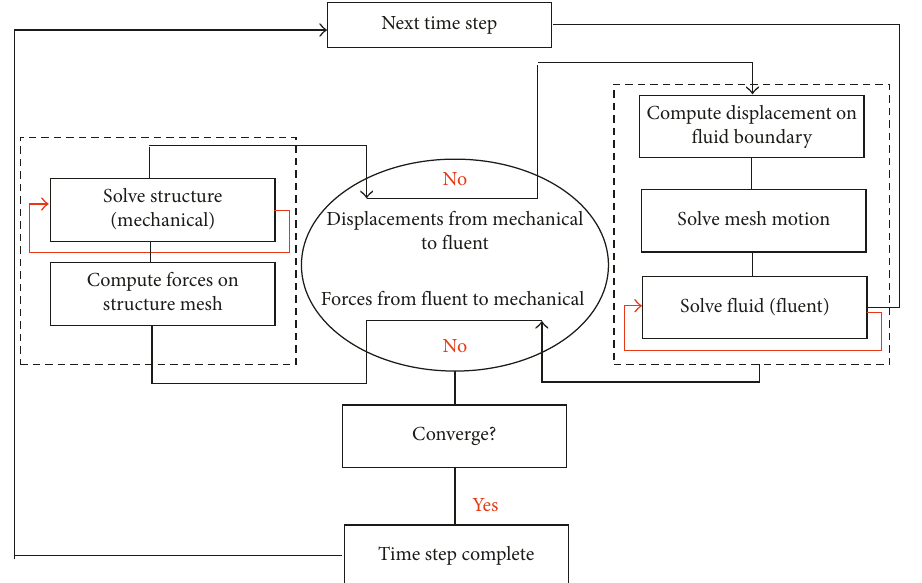
Figure 5: Flow chart for multifield simulations with